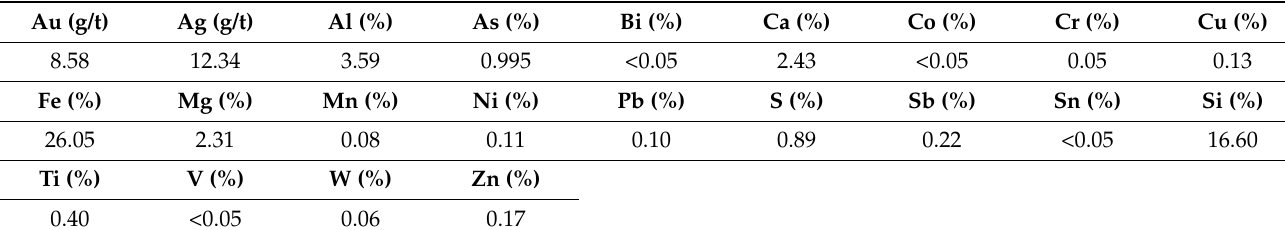
Table 5. Bulk chemical